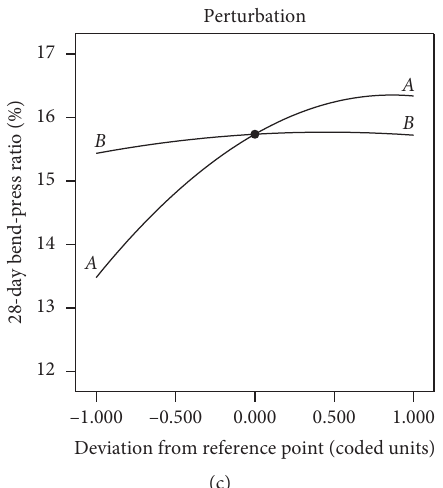
Figure 13: Perturbation plot for (a) 28-day compressive strength (R1); (b) 28-day flexural strength (R2); (c) 28-day flexural-compressive ratio